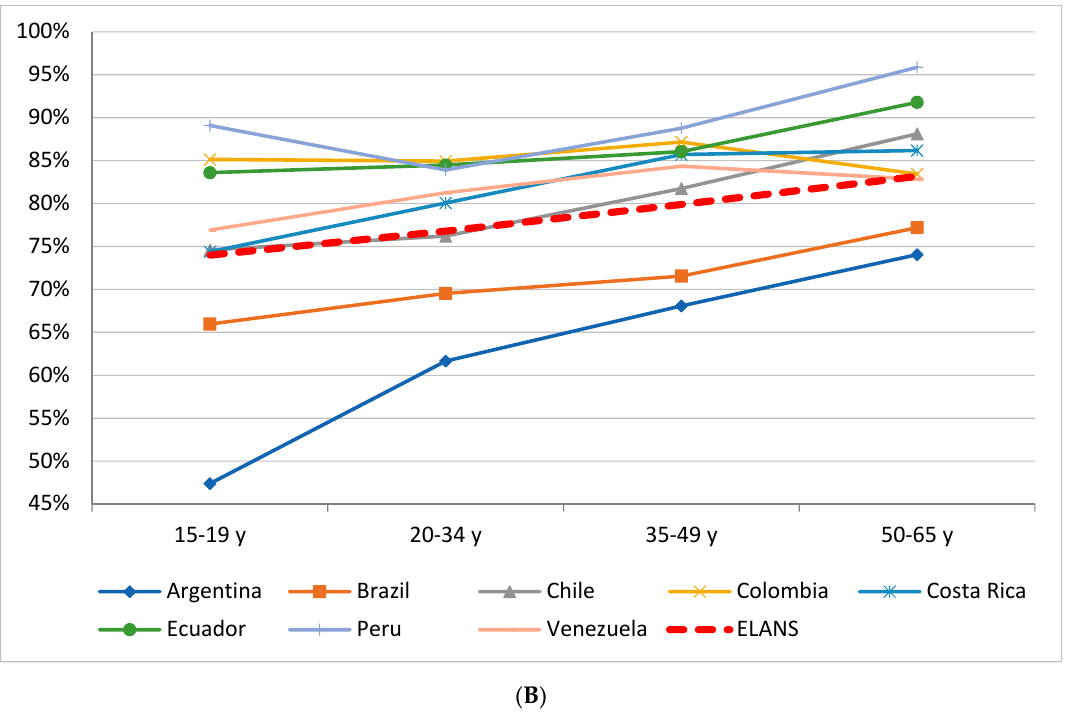
Figure 1. Proportion of regular breakfast consumers ( n = 7247), occasional consumers ( n = 1467) and breakfast skippers ( n = 504) by country ( A ) and proportion of regular breakfast consumers by country and age group ( B ).